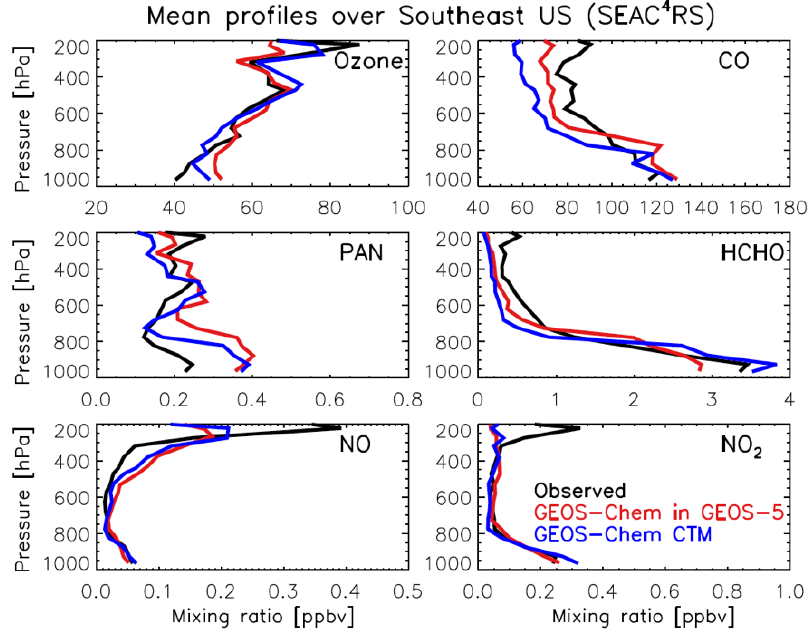
Figure 6. Mean vertical profiles of trace gas concentrations over the southeast US during the NASA Studies of Emissions, Atmospheric Composition, Clouds and Climate Coupling by Regional Surveys (SEAC 4 RS) aircraft campaign (August–September 2013; Toon et al., 2016). Results from the GEOS-5 Nature Run with GEOS-Chem chemistry are compared to observations for ozone and NO x , CO, peroxyacetyl nitrate (PAN), and formaldehyde (HCHO), and to the GEOS-Chem CTM (nested 0 . 25 ◦ × 0 . 3125 ◦ version in Travis et al., 2016). Model results are sampled along the flight tracks at the time of